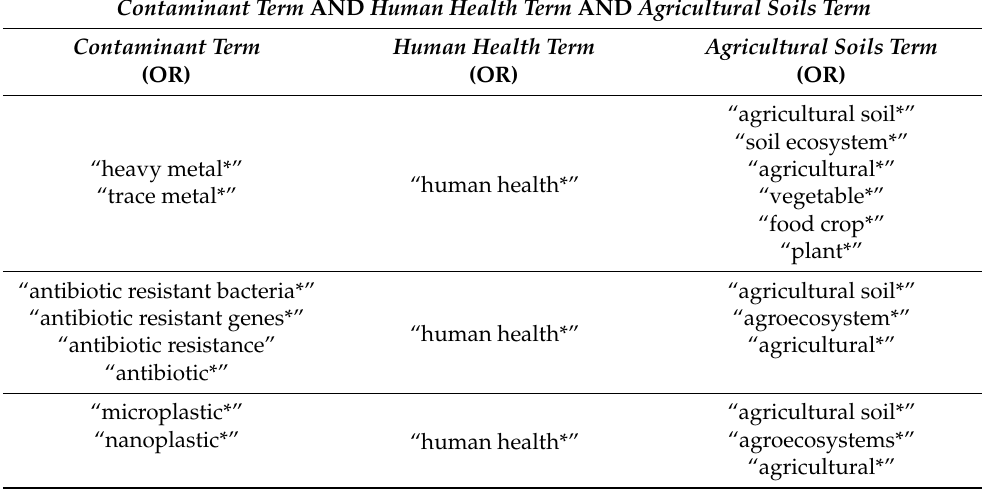
Table 1. Search terms used in the keyword search. All search strings were a combination of a contaminant term AND a human health term AND an agricultural soils term. Search String: Contaminant Term AND Human Health Term AND Agricultural Soils